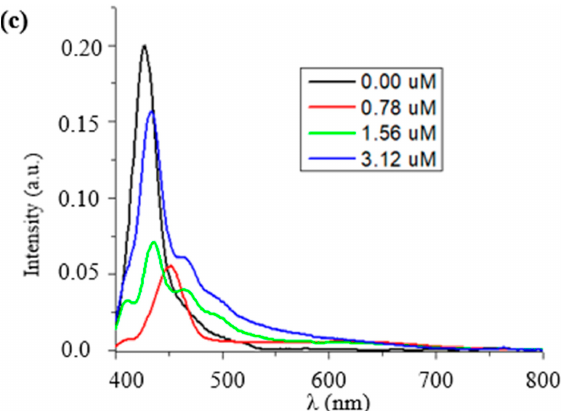
Figure 4. ( a ) UV–Vis spectra of doped and undoped CdS/ZnS core/shell nanoparticles; ( b ) bandgap calculation of all samples using Tauc plot; ( c ) Photoluminescence (PL) spectra of all samples (the photoluminescence intensity was found to initially decrease and then gradually increase with increasing concentration of Cu ions. The excitation peak was observed at a wavelength of 620 nm). Furthermore, photoluminescence spectroscopy (Spectra Physics Tsunami, CA, USA) was used to investigate the PL spectra of fabricated core/shell QDs. Figure 5 demonstrates the PL spectra of undoped and doped CdS/ZnS core/shell QDs for various pre-considered concentrations of doping. The emission peak of Cu-doped CdS/ZnS core/shell QDs was initially red-shifted in comparison with the undoped CdS/ZnS QDs. However, as the Cu concentration increased, the emission peak blue-shifted and exhibited increased intensity, contrary to other reports [3]. Furthermore, with increasing Cu concentration, new peaks were observed in PL spectra.